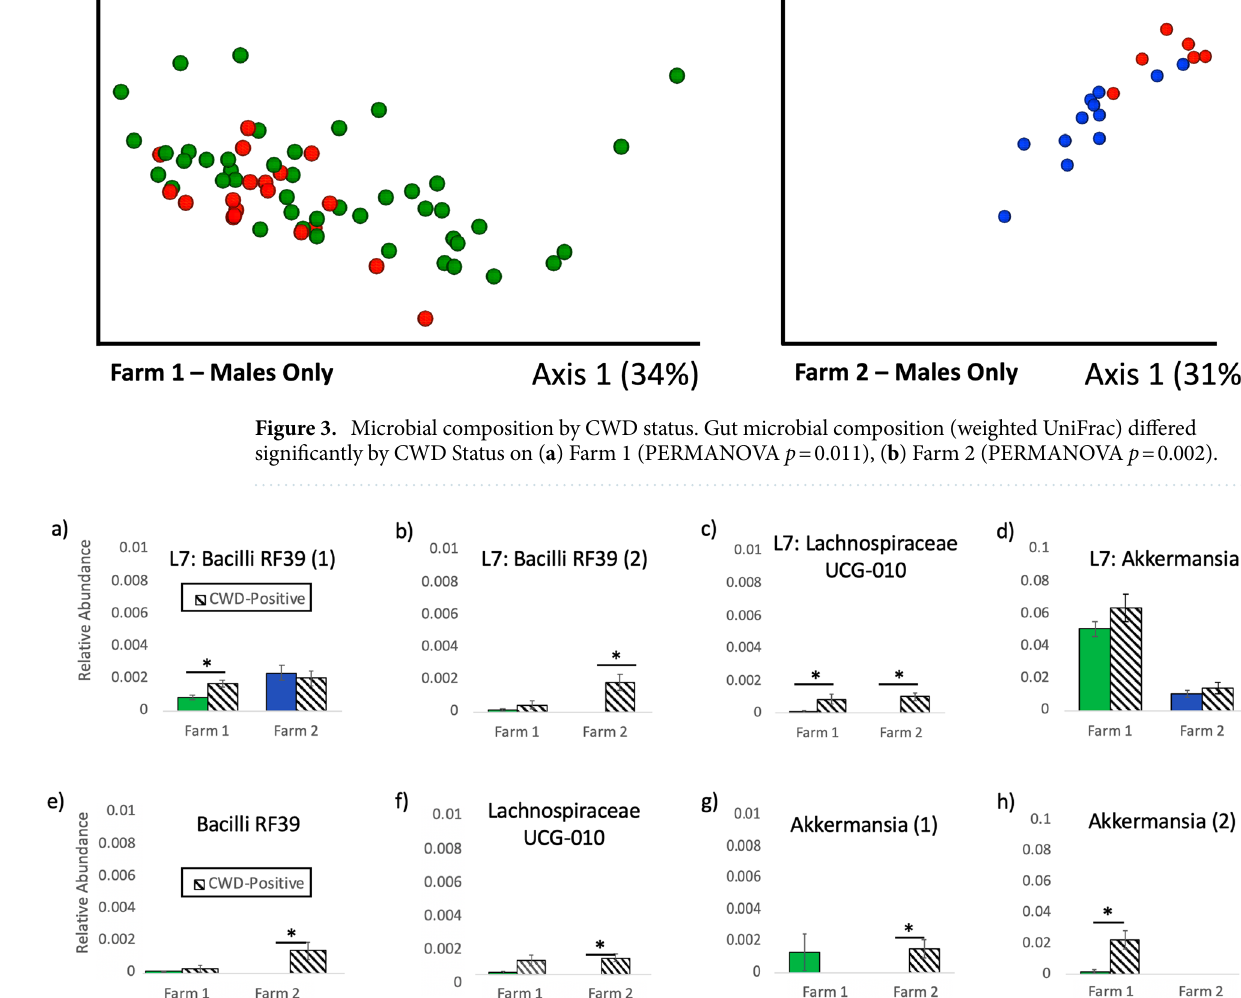
lyze only male deer in relation to CWD status. The single CWD-positive female deer was still included in data visualizations. Microbial composition differed significantly in CWD-positive deer on both farms (Males only; Farm 1: Unweighted UniFrac PERMANOVA p = 0.003 Weighted UniFrac PERMANOVA p = 0.011; Farm 2: Unweighted UniFrac PERMANOVA p = 0.003, Weighted UniFrac PERMANOVA p = 0.002; Fig. 3, Supp. Fig. 3). Increased microbial diversity (Shannon Index), although not significant, was also observed in CWD-positive males on both farms (Farm 1 p = 0.07; Farm 2 p = 0.26; Fig. 2d). We further discovered several differentially abundant microbes at the L7 and ASV levels between CWD- positive and CWD non-detect males on both farms. (Note, multiple ASVs may be classified as a single L7, roughly species level, taxa.) On Farm 1, at the L7 level, multiple taxa were differentially abundant between CWD-positive and CWD non-detect males, the top four of which included: an uncultured bacterium from the class Bacilli (formerly Mollicutes), order RF39, increased in CWD-positive males (ANCOM W = 80; Fig. 4a); an uncultured Paludibacter species increased in non-detect males (ANCOM W = 54); an uncultured bacterium